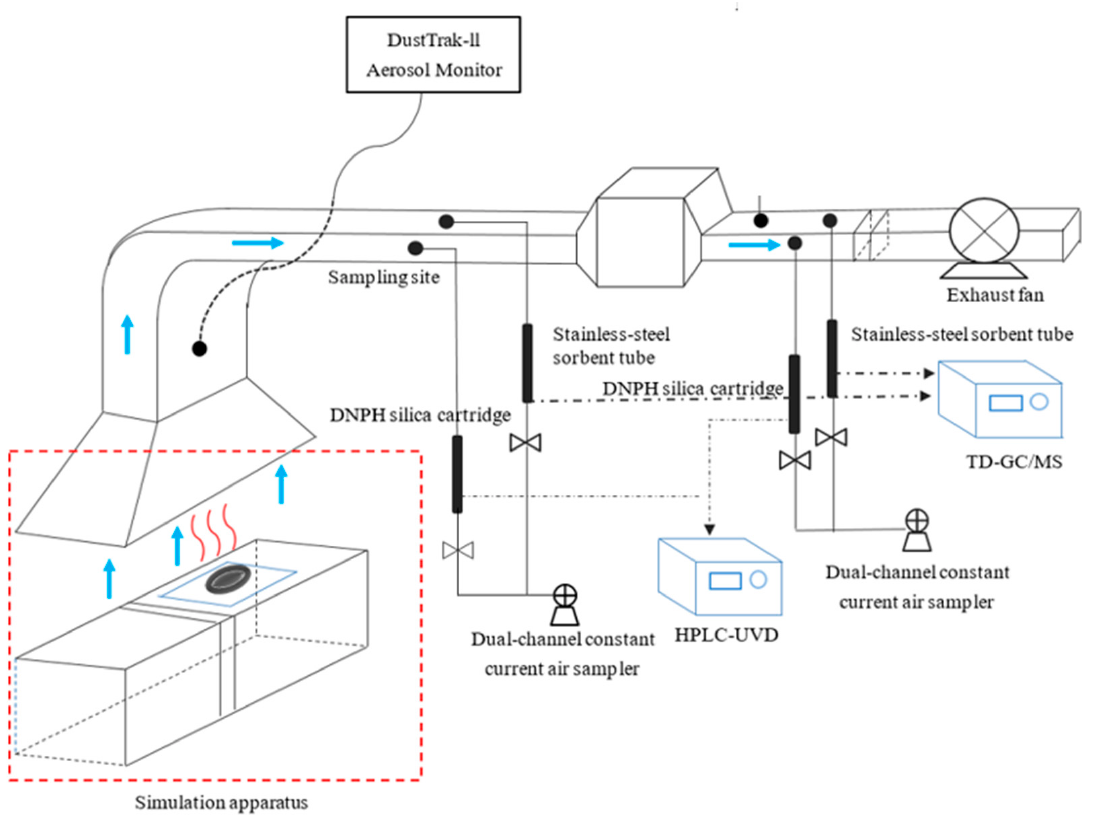
Figure 1. Schematic diagram of the test facility and grilling experiments.